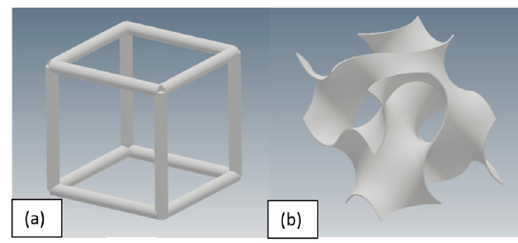
Figure 1. Unit cell architecture: ( a ) cube; and ( b ) gyroid.